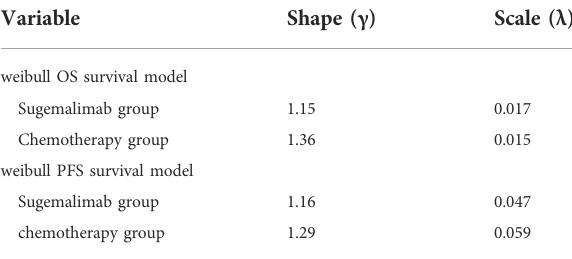
TABLE 1 Survival Estimates